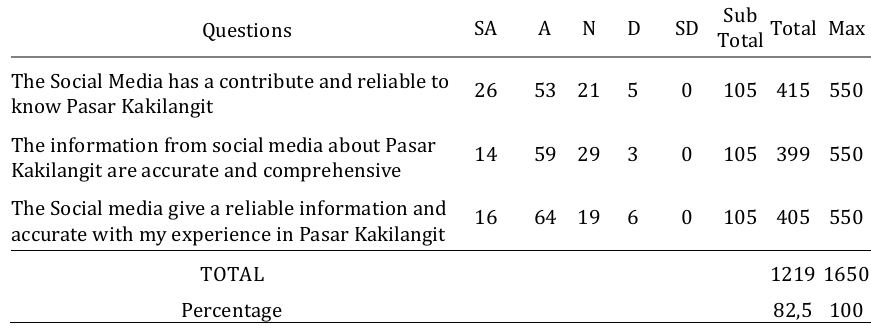
Table 2 Consumption Data Findings (n=105)